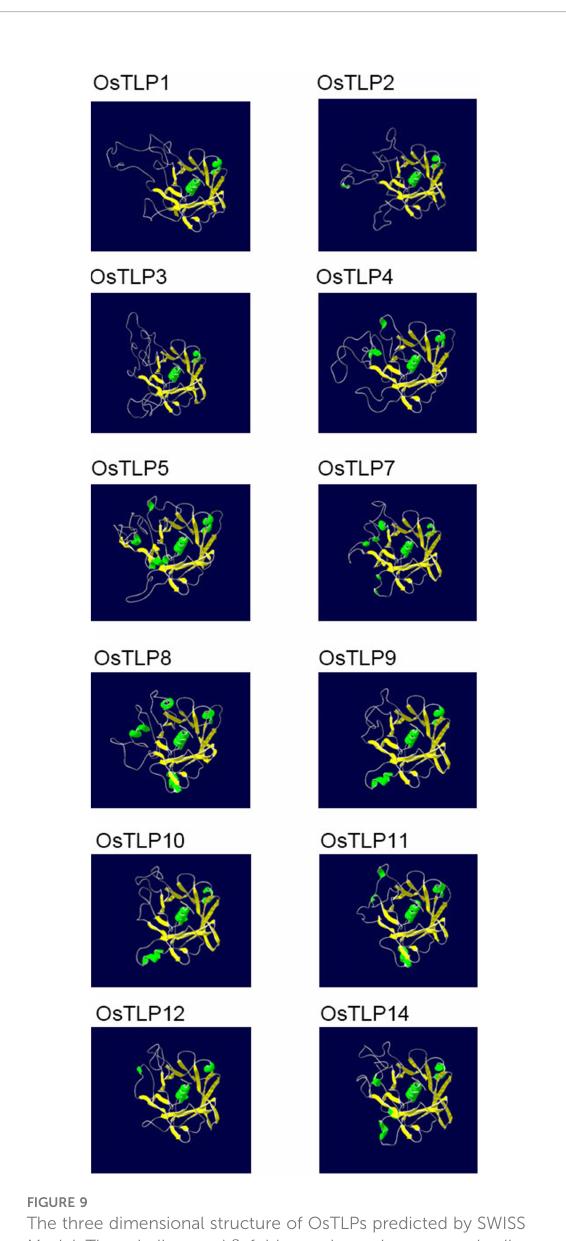
FIGURE 9 The three dimensional structure of OsTLPs predicted by SWISS Model. The a helixes and b -folds are shown in green and yellow,